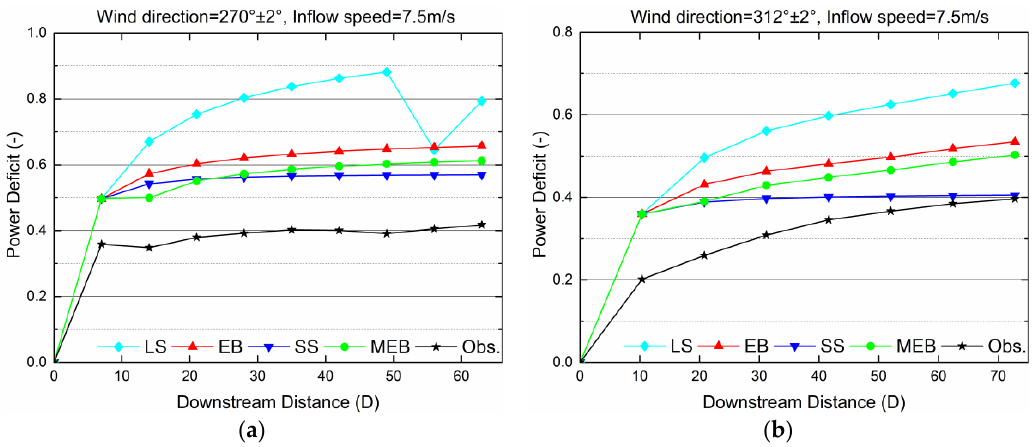
Figure 8. Horns Rev I power deficit in ( a ) a row with 7D spacing and 270 ± 2°, and ( b ) a row with 10.4D spacing and 312 ±